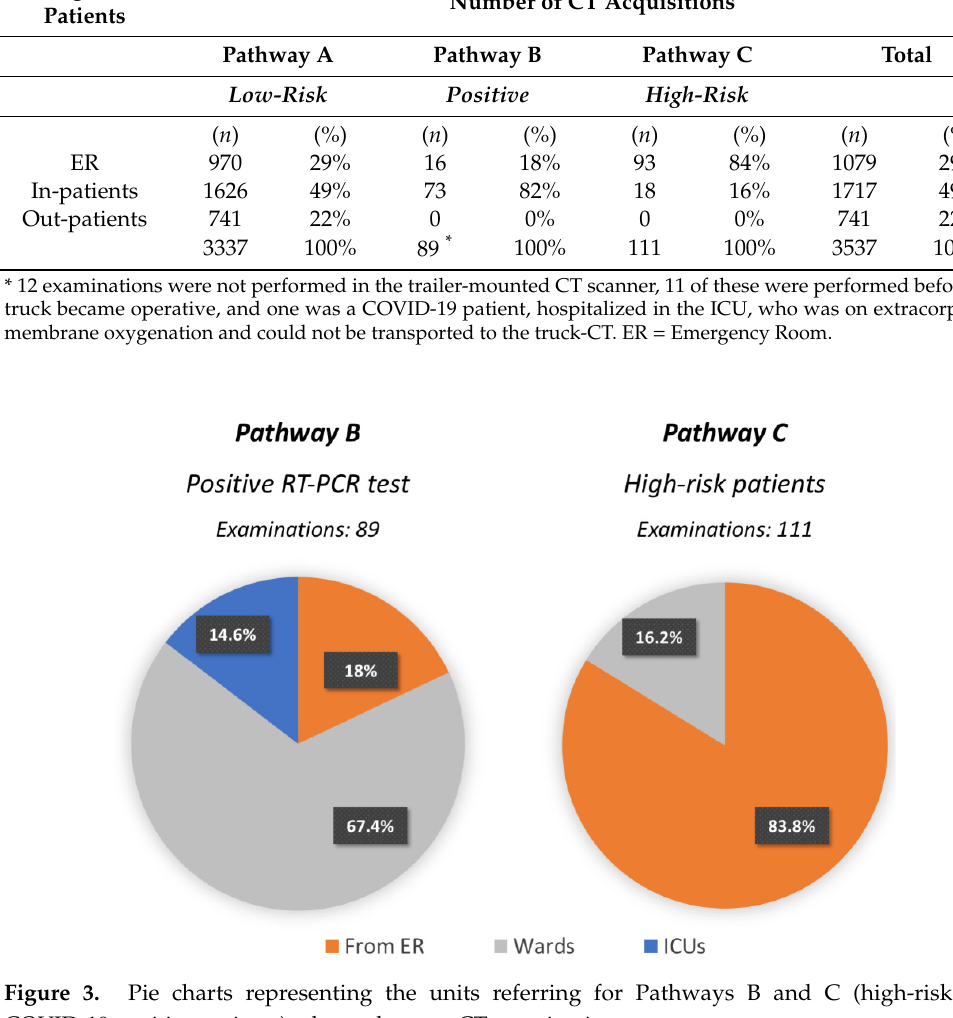
Figure 3. Pie charts representing the units referring for Pathways B and C (high ‐ risk and COVID ‐ 19 ‐ positive patients) who underwent CT